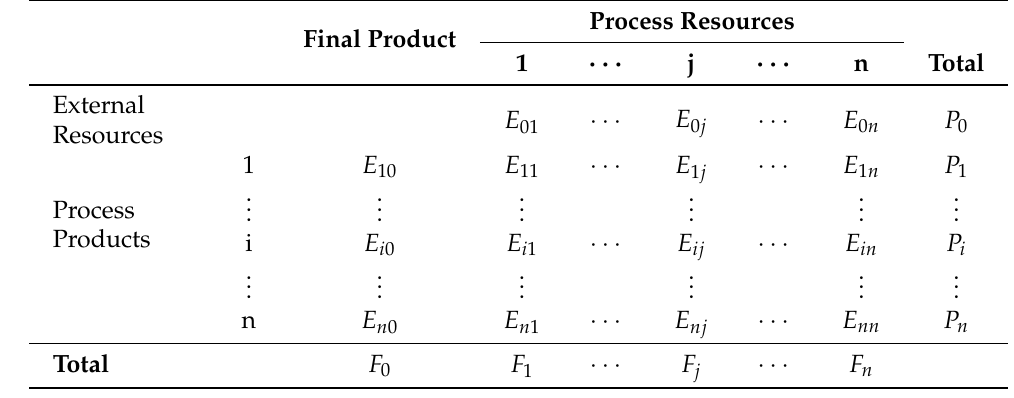
Table 6. Fuel–Product